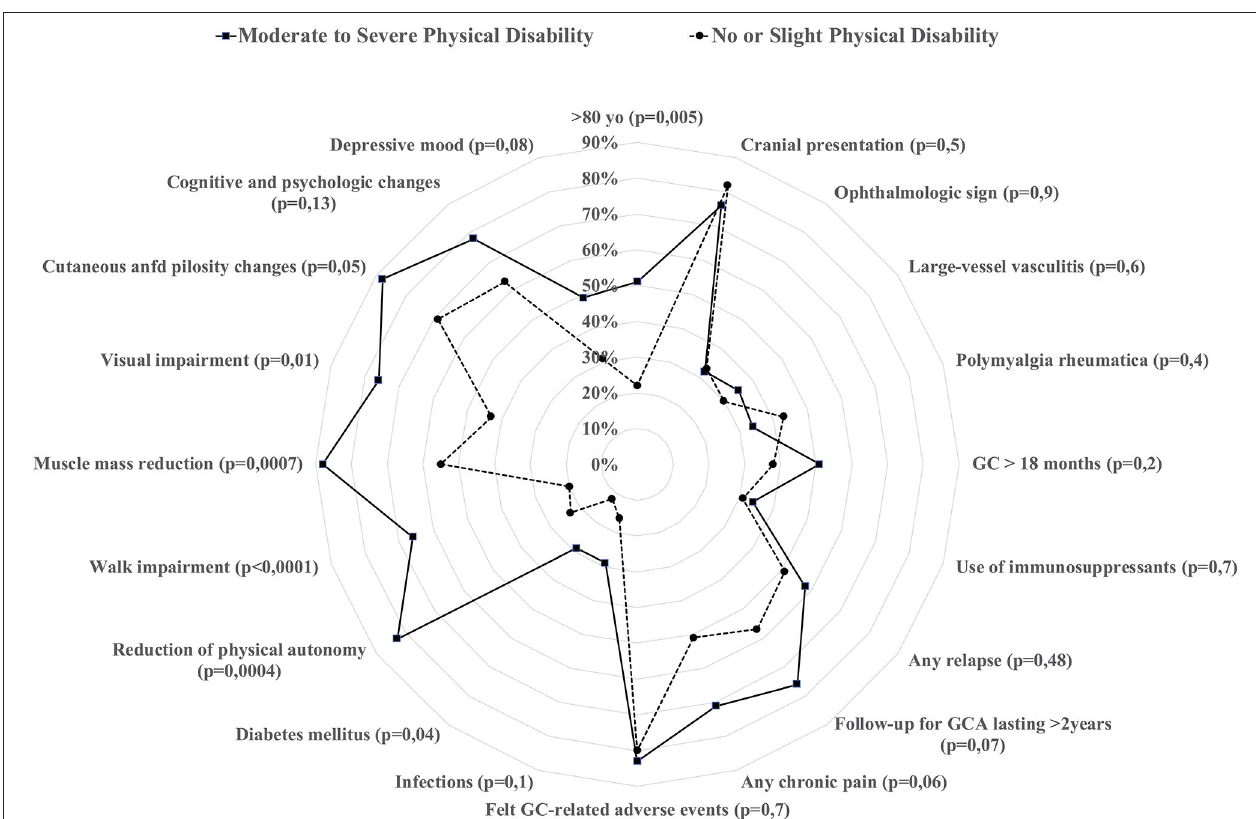
FIGURE 1 | Comparison of different characteristics at GCA baseline and during follow-up according to whether the patients stated they suffered from moderate-to-severe physical disability (calculated through the SF-12